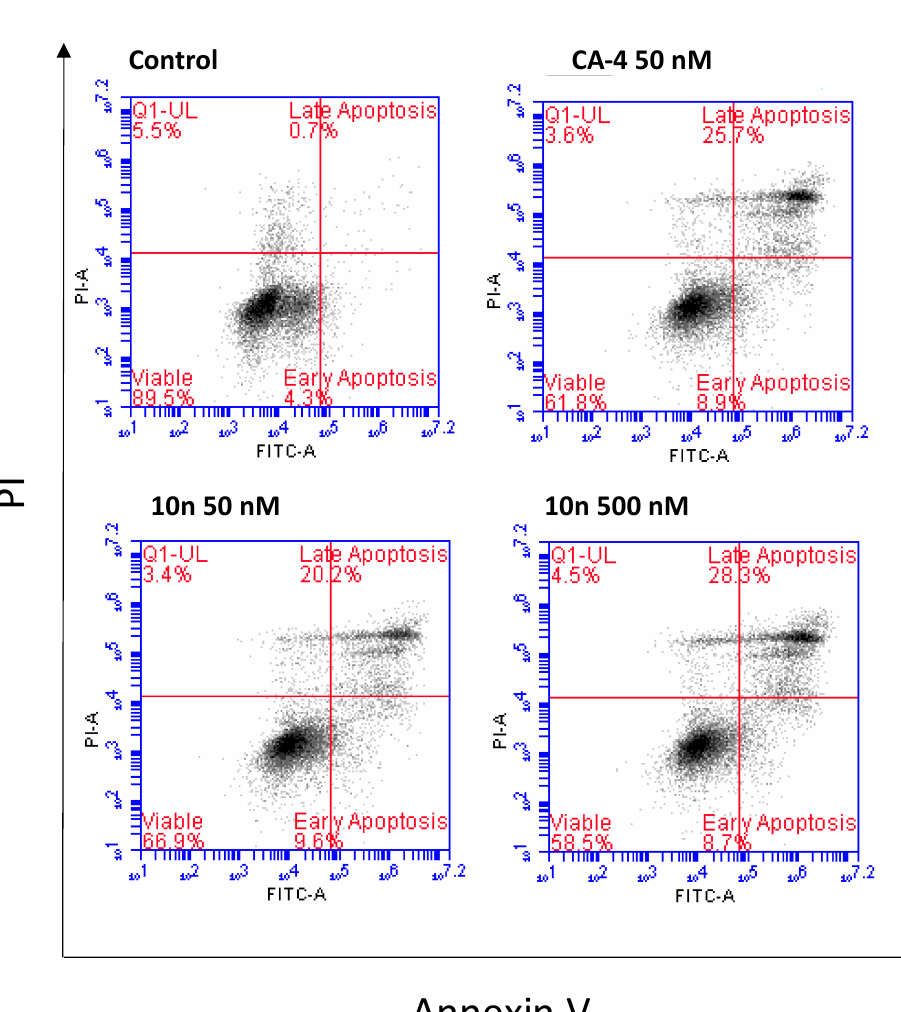
Figure 6. Compound 10n induced apoptosis in MCF-7 breast cancer cells at 48 h. MCF-7 breast cancer cells were treated with 10n (50 and 500 nM) or CA-4 (50 nM) or control vehicle (0.1% ethanol ( v / v )). The percentage of apoptotic cells was determined by staining with Annexin V-FITC and propidium iodide (PI). In each panel, the upper left quadrant shows only PI cells that are necrotic, while the lower left quadrant shows cells that are negative for both PI and Annexin V-FITC. The upper right quadrant shows both Annexin/PI positive, which are in late apoptosis/necrosis, while the lower right quadrant shows Annexin positive cells that are in the early apoptotic stage. Cells treated with CA-4 (50 nM) and 10n (50 and 500 nM) and control cells at 48 h are shown, respectively. Values represent the mean of three independent experiments. Table 8. Inhibition of tubulin polymerisation for compounds 10e , 11n and CA-4 and their